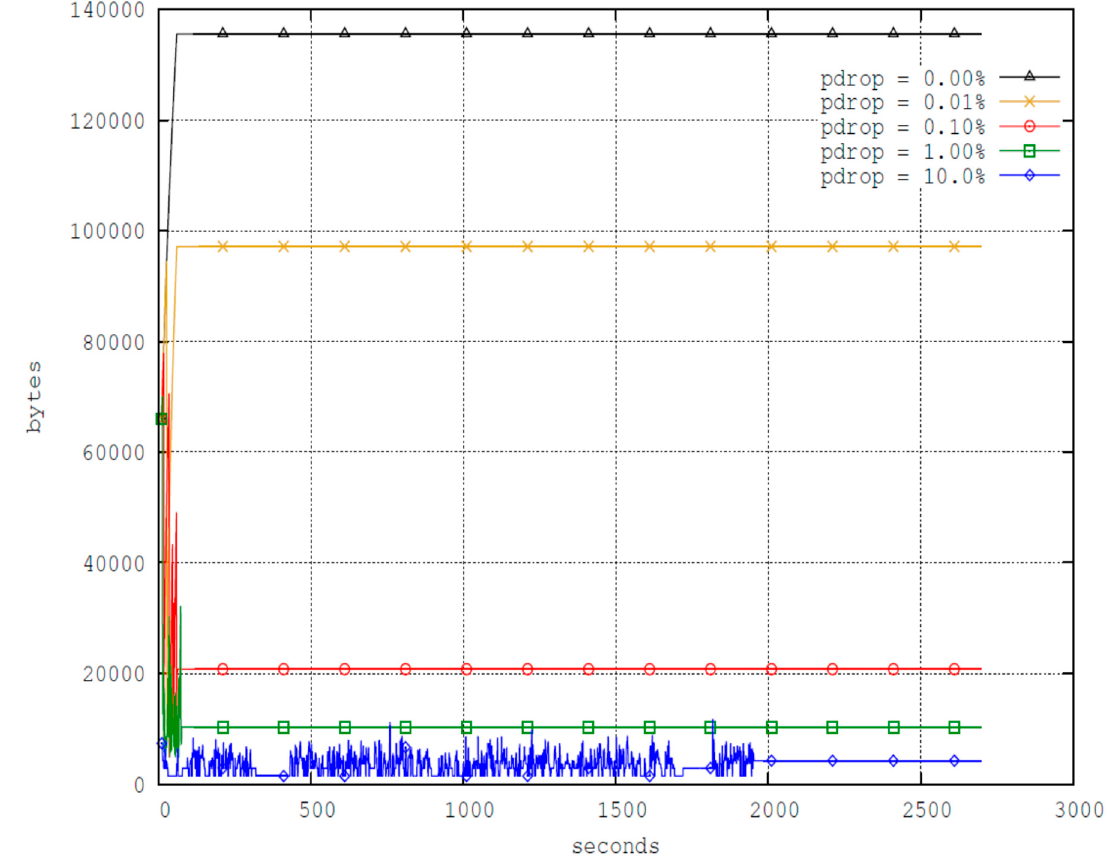
Figure 2. Effect of TCP Congestion Window Size on Packet Dropping.